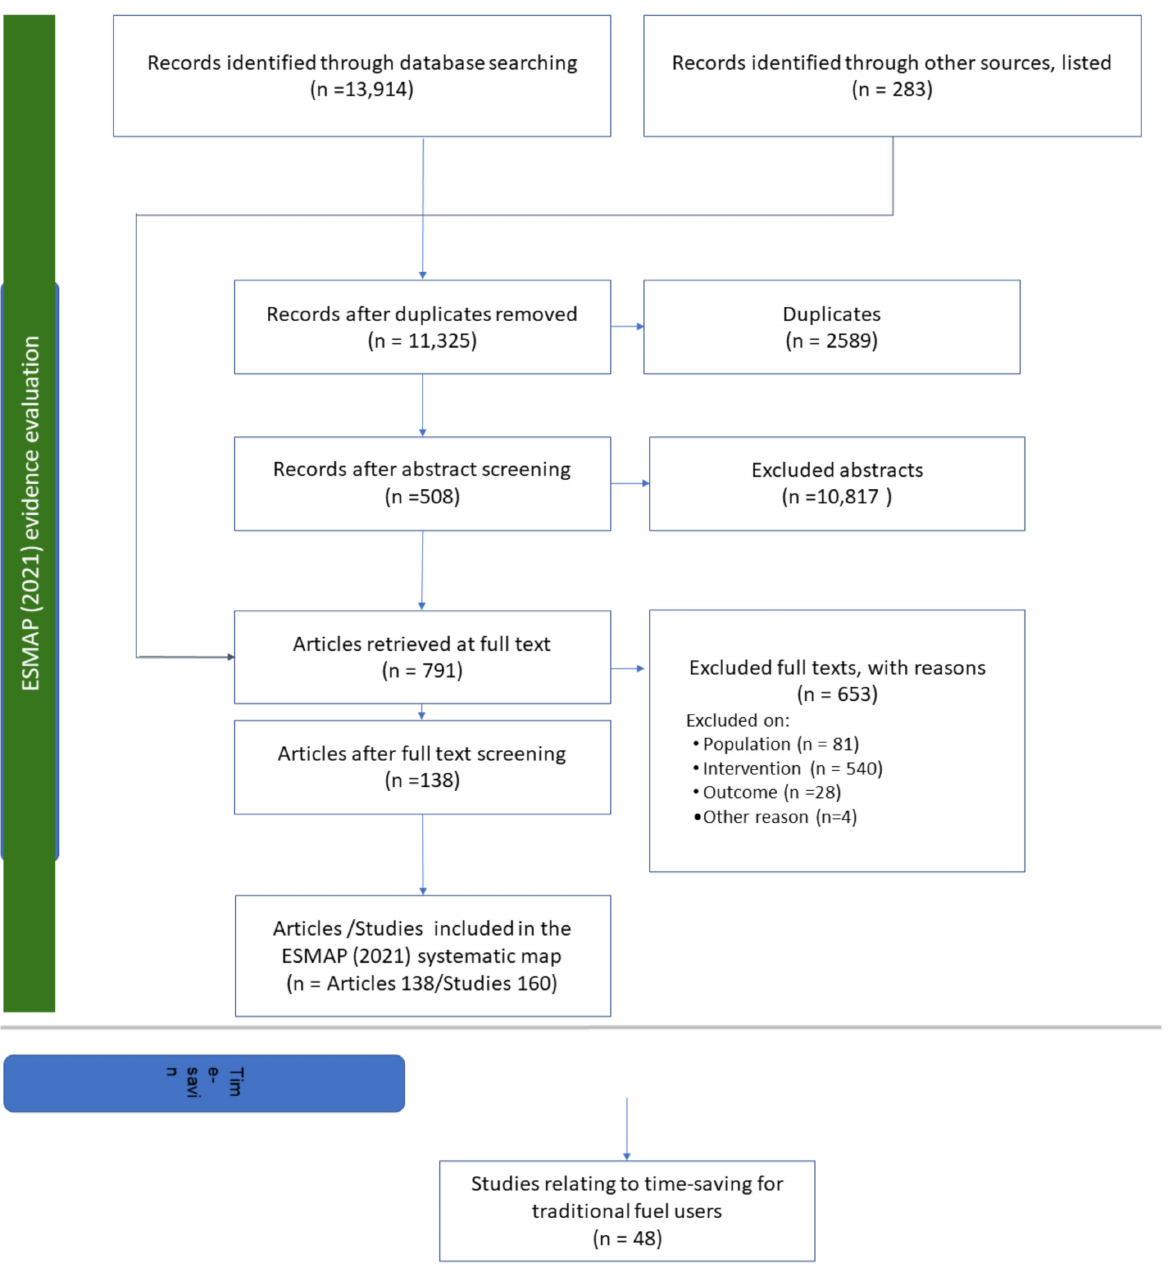
Figure 1. Flowchart of screening decisions (adapted from Haddaway et al.